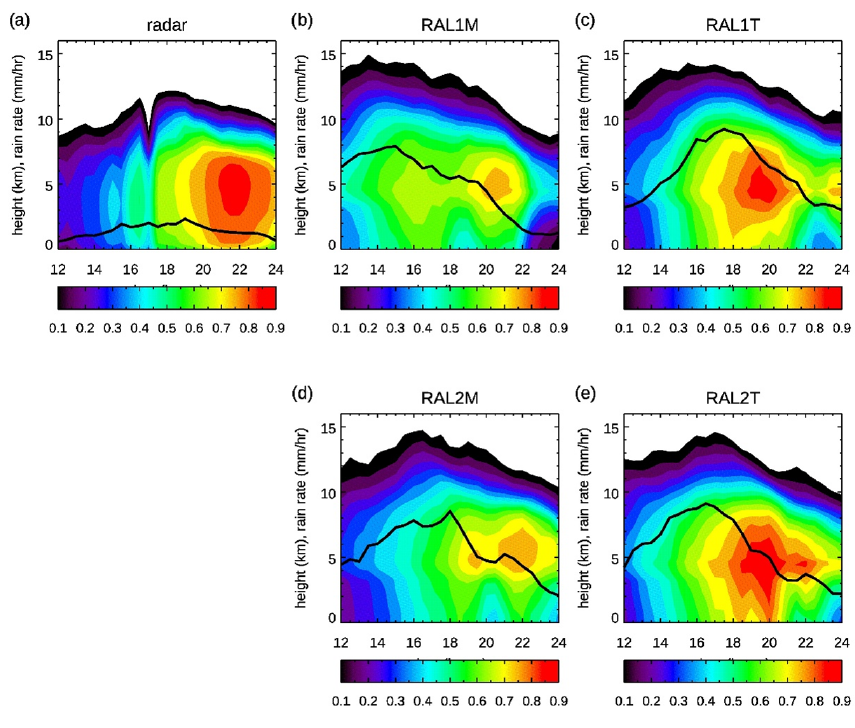
Figure 12. Fraction of radar area covered by reflectivities greater than 10dBZ as a function of height and time (coloured contours) from 12:00 to 24:00UTC on 18 February 2014. Solid lines are the time series of the domain mean rain rate (mmh − 1